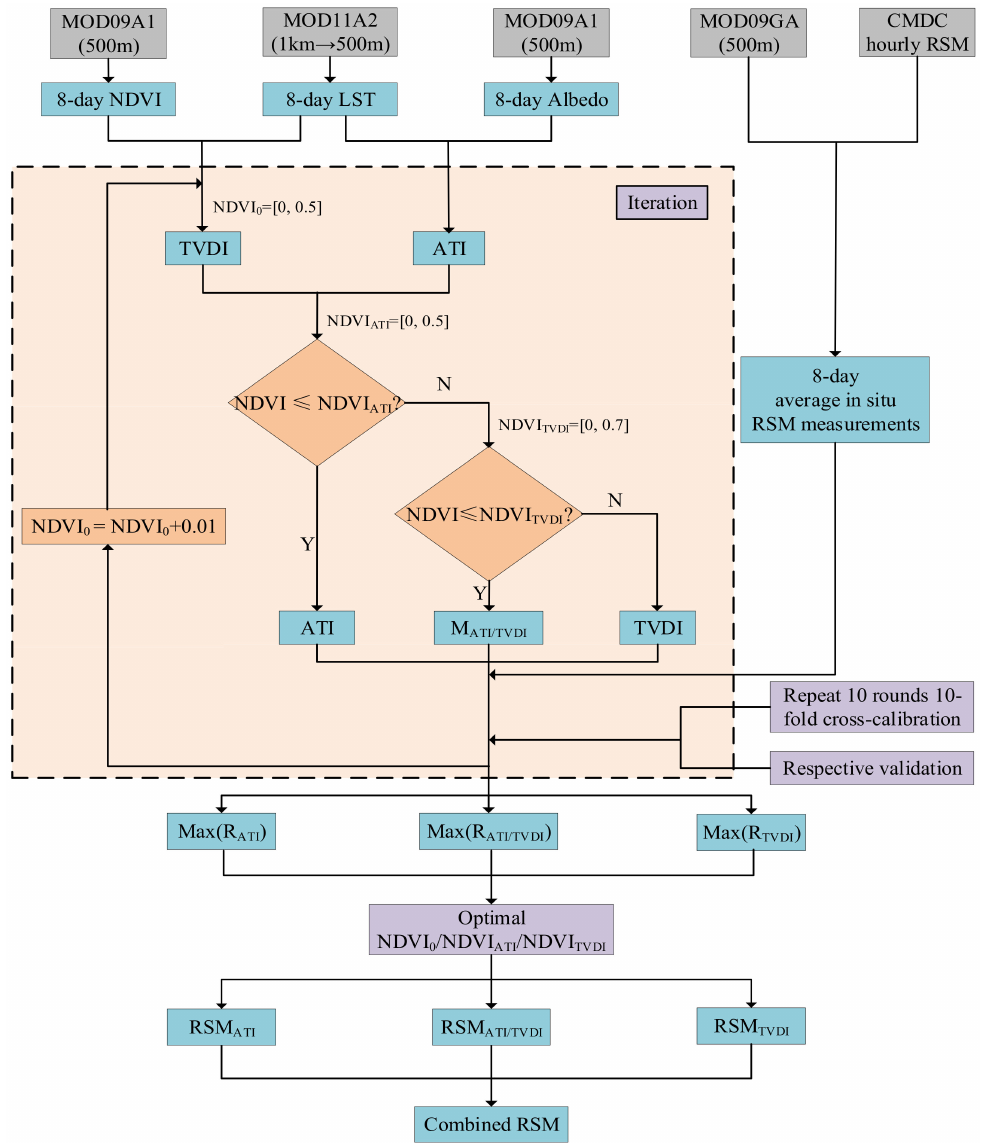
Figure 4. Flowchart of SM estimation by the ATI-based model, the TVDI-based model, and the ATI / TVDI joint